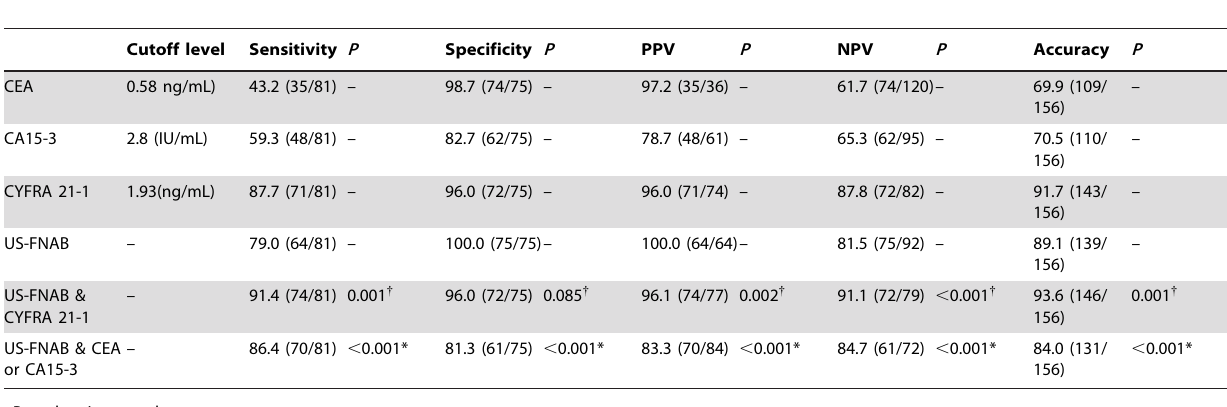
Table 2. Diagnostic performances of CEA, CA15-3 and CYFRA 21-1 at cutoff levels, US-FNAB alone, and US-FNAB combined with each tumor marker.